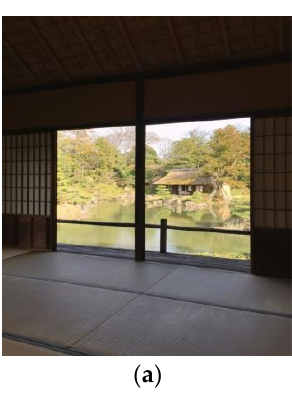
Figure 1. ( a ) Looking out at the water from the interior of the Moonwave Building; ( b ) moon and water; ( c ) Moonwave House.